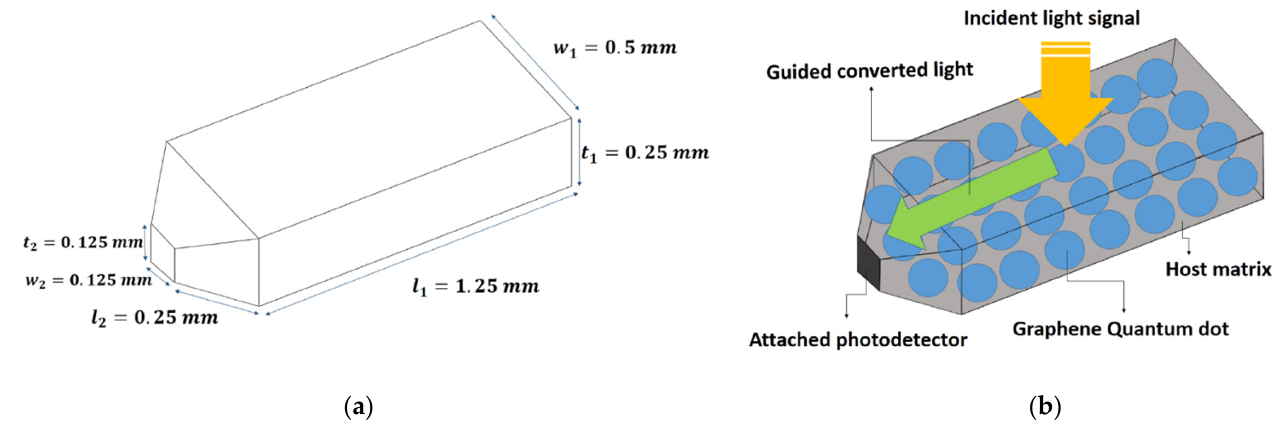
Figure 1. Schematics of the proposed optical antenna. ( a ) Dimensions of the proposed optical antenna. ( b ) Configuration of components in the optical antenna (host matrix, Graphene Quantum Dots (GQDs), photodetector, incident light, and guiding light).